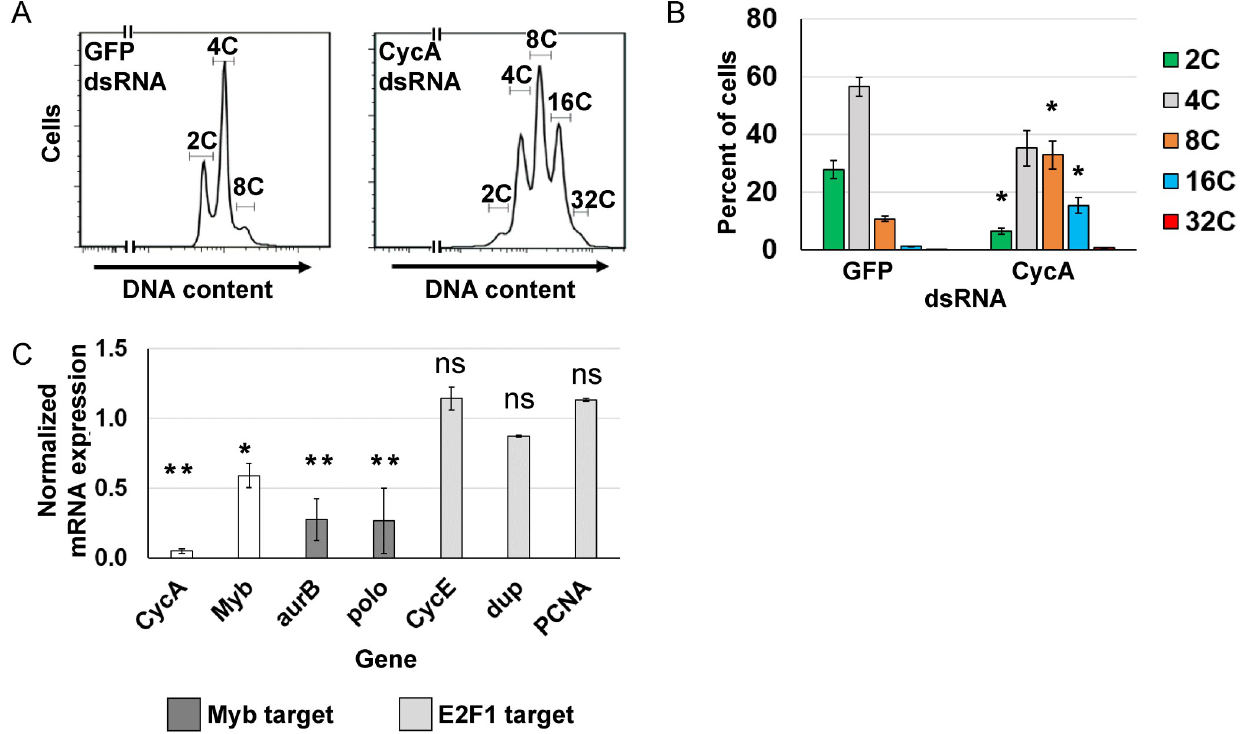
Fig 1. Knockdown of Cyclin A induces endoreplication cycles. (A) Flow cytometry of DNA content in propidium iodide labeled S2 cells 96 hours after treatment with either GFP dsRNA (control) or CycA dsRNA. (B) Quantification of the ploidy classes after GFP or CycA dsRNA treatment. Mean and S.E. M. for N = 3, � —p < 0.05 comparing each CycA dsRNA ploidy class with the corresponding ploidy class in control GFP dsRNA treated cells. (C) qRT-PCR analysis of select Myb and E2F1 target gene expression in CycA dsRNA iECs. Normalized mRNA is the ratio of mRNA levels in CycA dsRNA divided by control GFP dsRNA cells (N = 3, mean and S.E.M., � —p < 0.05, �� —p < 0.01, ns—not